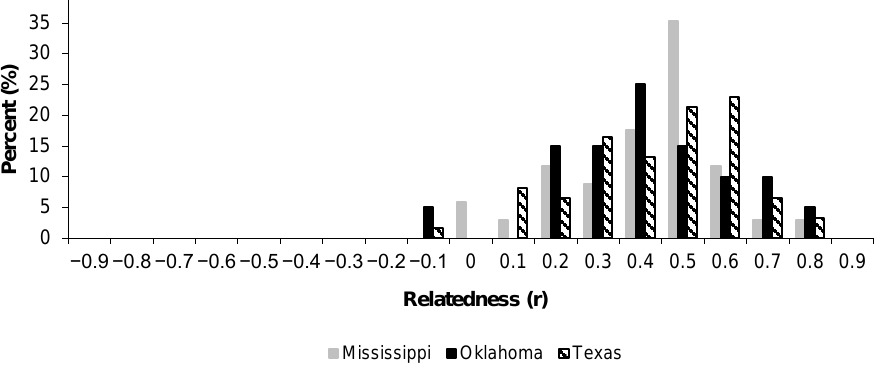
We detected higher levels of r by using known sibling pairs from all three study areas. The mean r was 0.415 (0.024), 0.405 (0.04), and 0.439 (0.022) for sibling pairs in Mississippi,